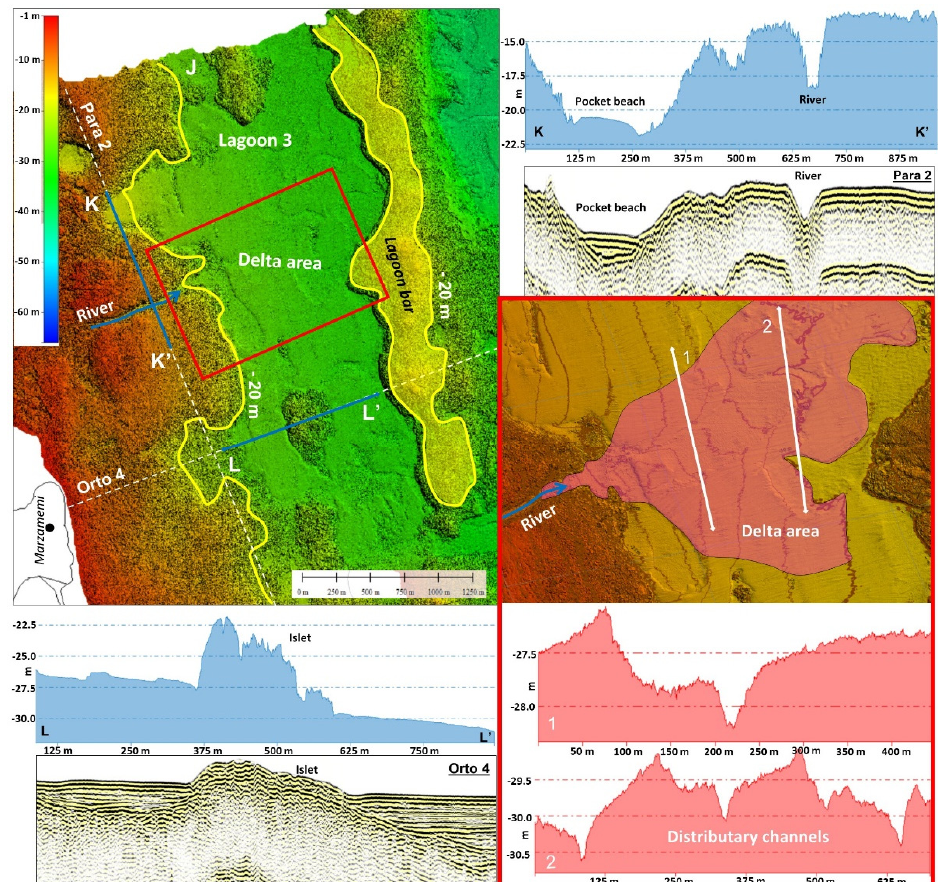
Figure 12. The main morphological features of Lagoon 3 (L3). The K–K ′ profile and the seismic profiles show the morpho-stratigraphic setting of the pocket beaches and of the main incision of this area. The box in red shows the peculiarities of the “delta area” in the central portion of L3. The L–L ′ profile and the seismic profile of Orto 4 show the morpho-stratigraphic setting of the islet in the southern portion of L3 .